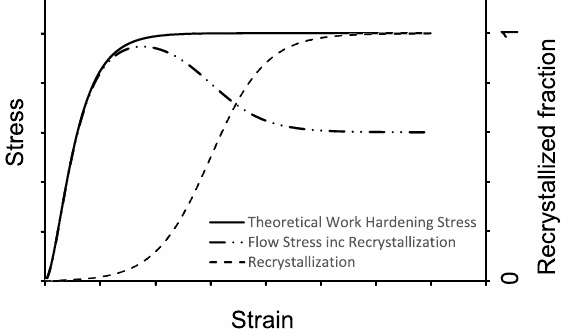
Figure 1. Avrami-based modeling of dynamic